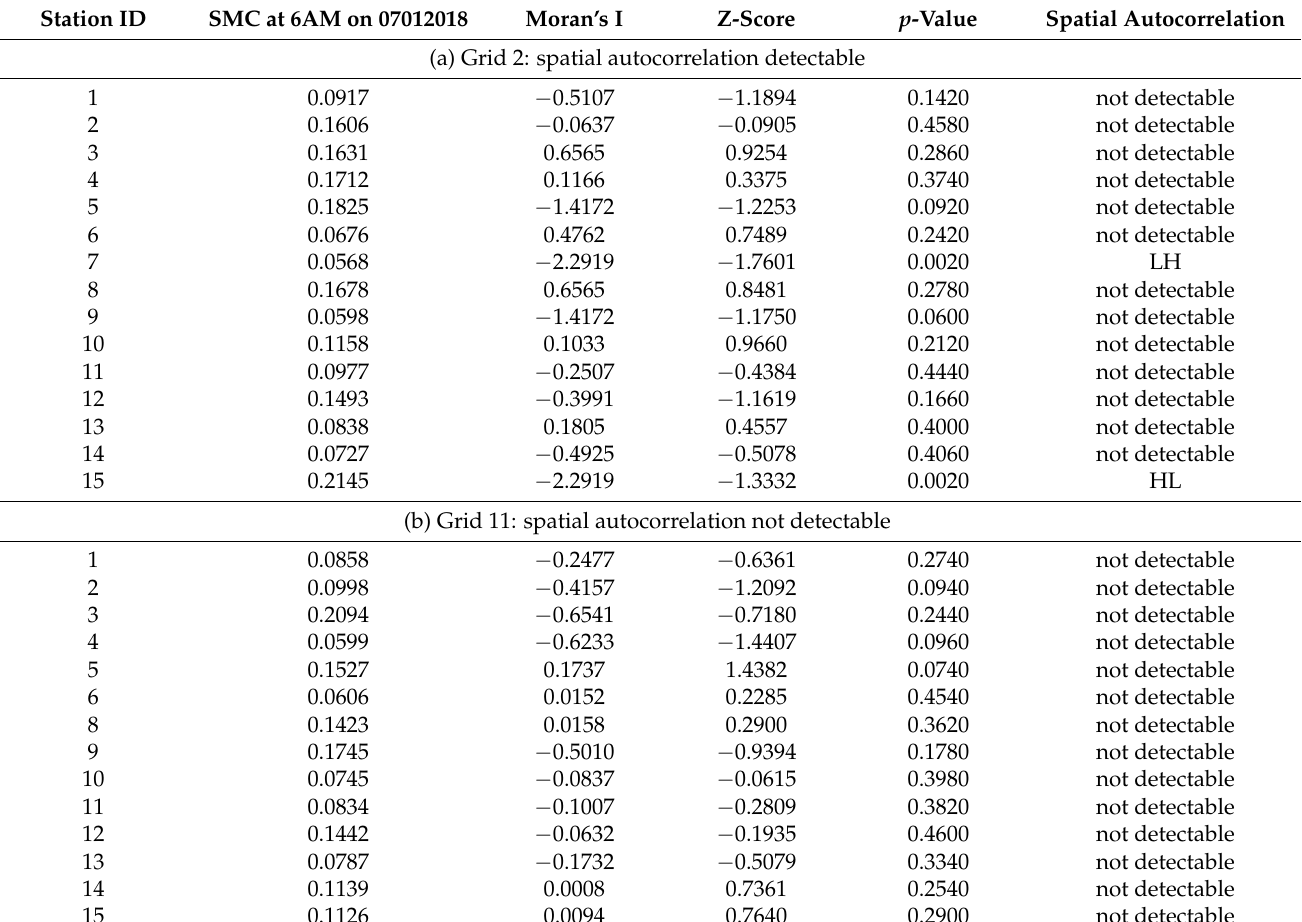
Table 2. Soil moisture stations detected with spatial autocorrelation with Moran’s I (a) detected two stations with spatial autocorrelation, LH = low–high outlier, HL = high–low outlier; (b) detected no spatial